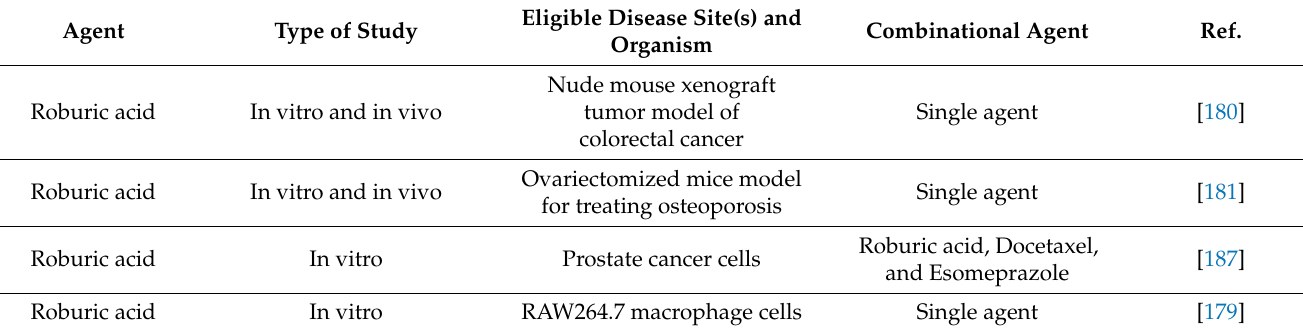
Table 5. Preclinical studies with roburic